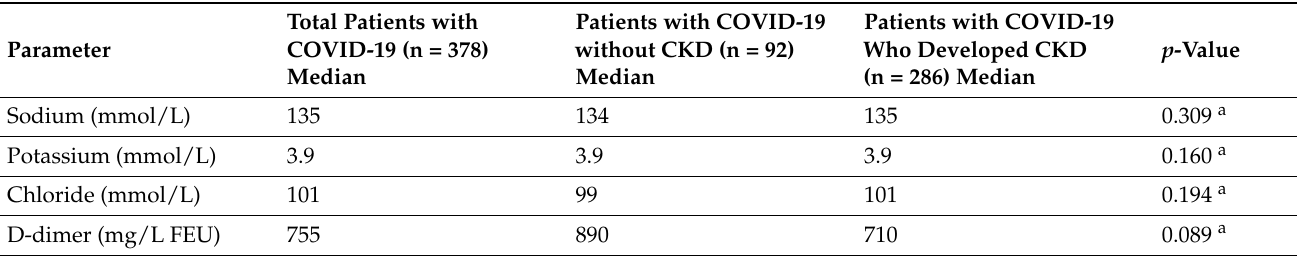
Table 3. Association between CKD status with laboratory tests.